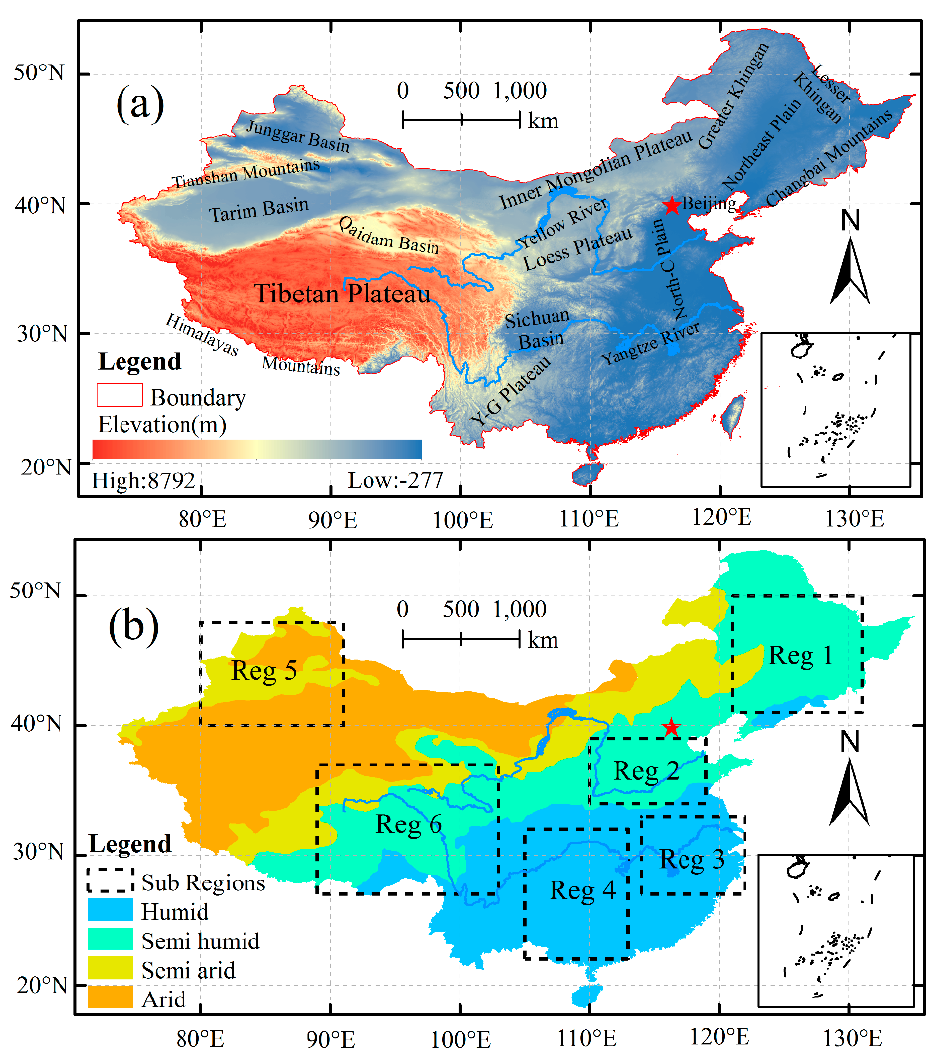
Figure 1. ( a ) Digital elevation map (DEM) of China; ( b ) spatial distributions of the four climate districts and locations of the six selected subregions.